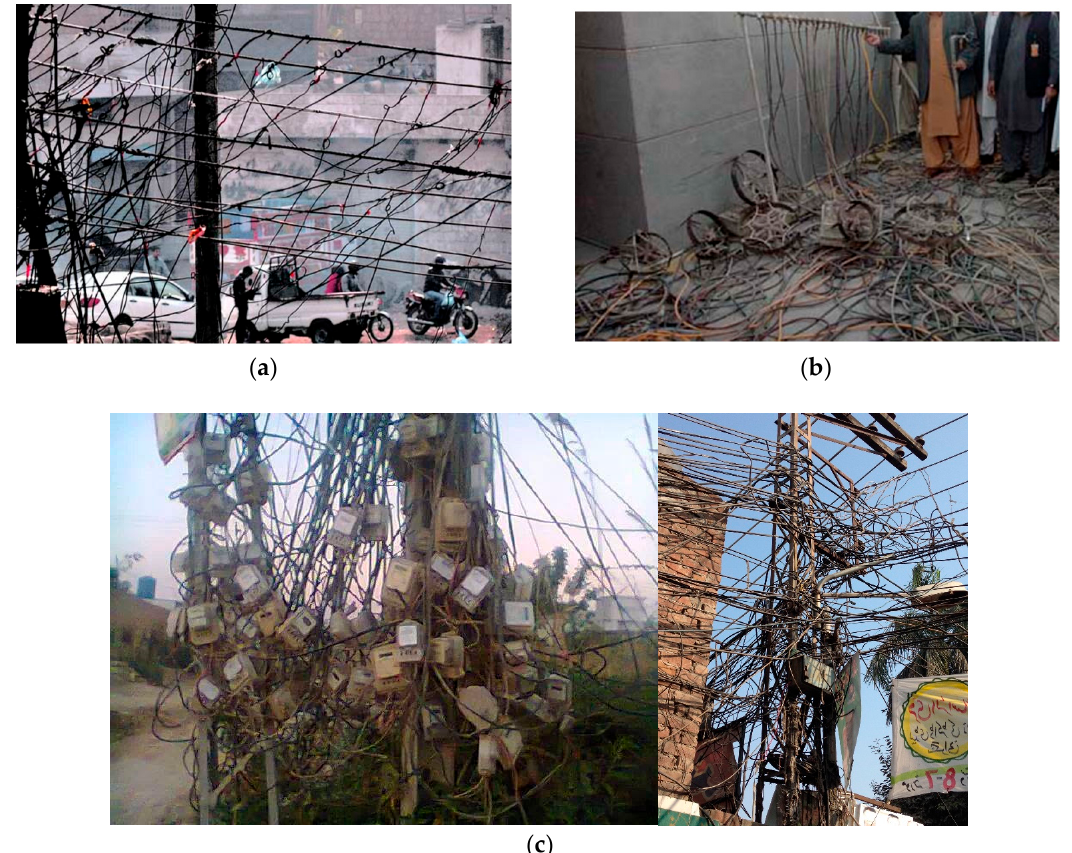
Figure 6. ( a ) Illegal electricity connections—the use of hook (kundas) on main electricity supply lines in Karachi, Pakistan, bypassing electric meters [39]; ( b ) Illegal gas connections in Lahore, Pakistan, bypassing gas meters [40]; ( c ) Conditions of electricity meters on electric poles (impossible to isolate energy consumption by consumer). Photo credit: unknown.